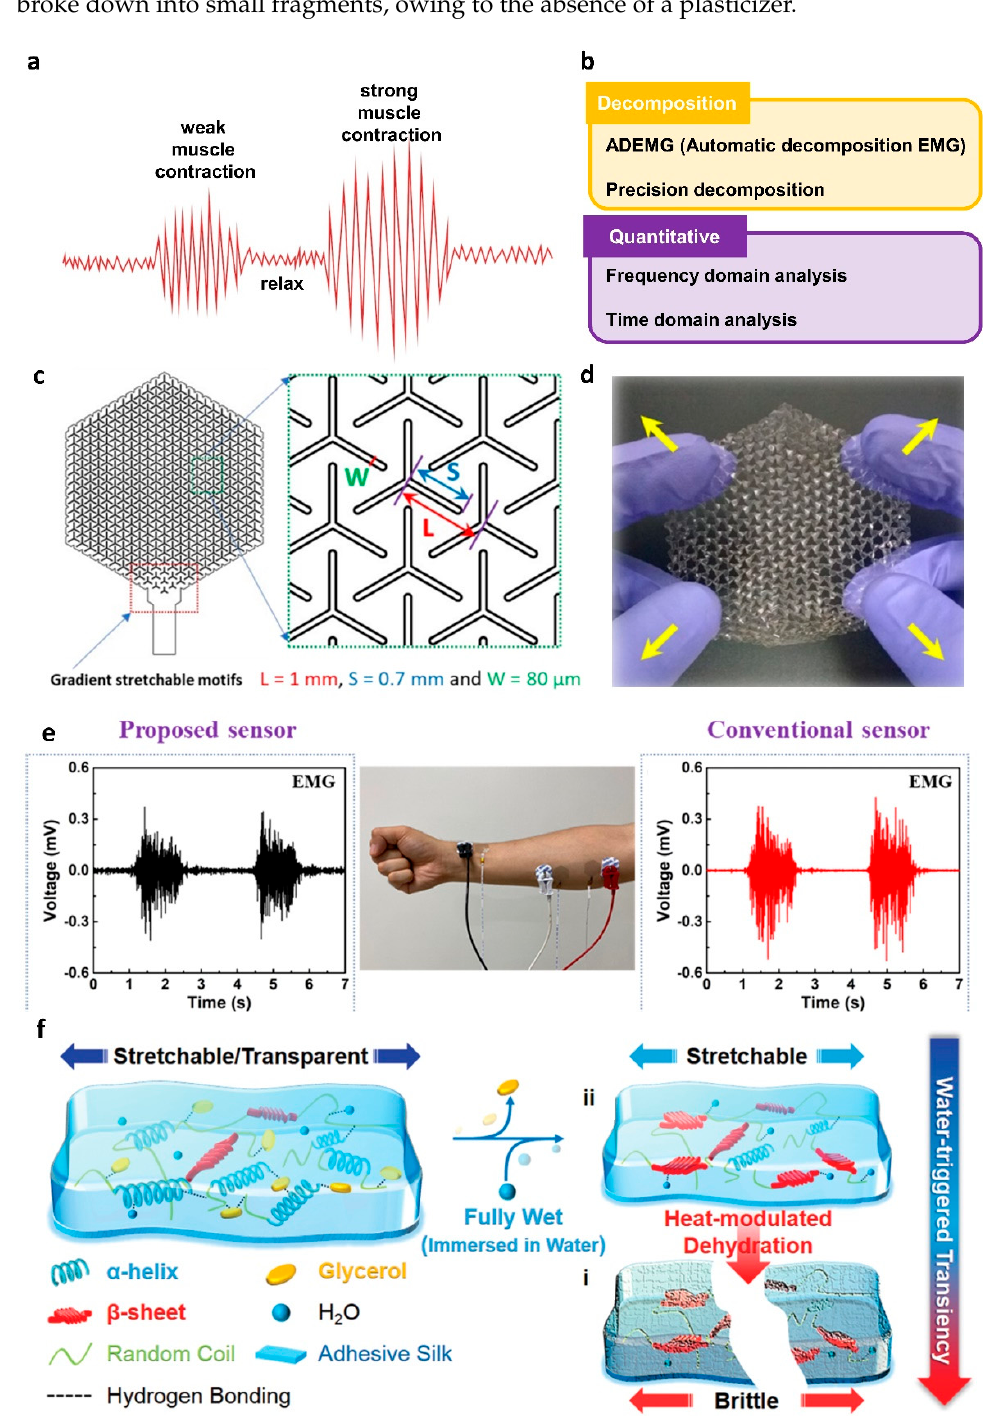
Figure 6. ( a ) Schematic of EMG in muscle contraction and relaxation; ( b ) table of quantitative EMG analysis; ( c ) design of the Y-shaped kirigami electrode; ( d ) photograph of the stretching characteristic of the Y-shaped kirigami electrode (adapted from [109] with permission from American Chemical Society); ( e ) EMG measurements for the proposed electrode and conventional electrode; ( f ) schematic of water-induced changes in GEPC substrate-based TEE electrodes (adapted from [110] with permission from the John Wiley and Sons).